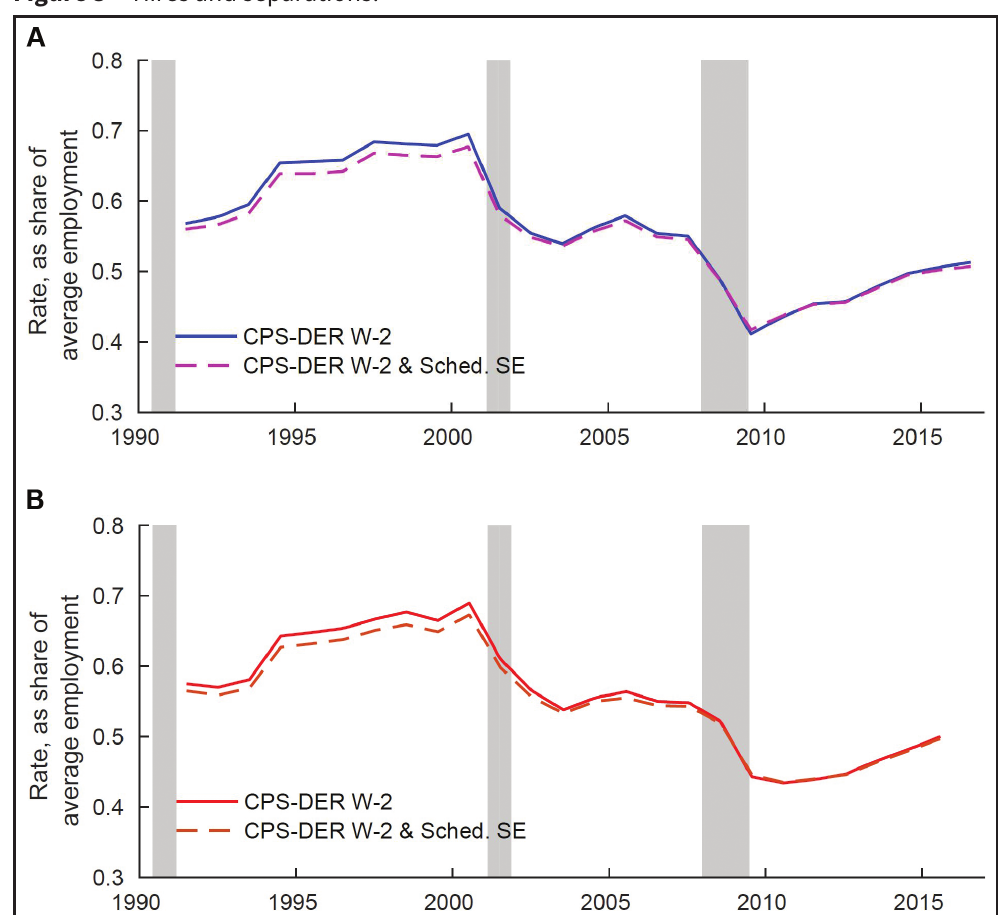
Figure 3 Hires and